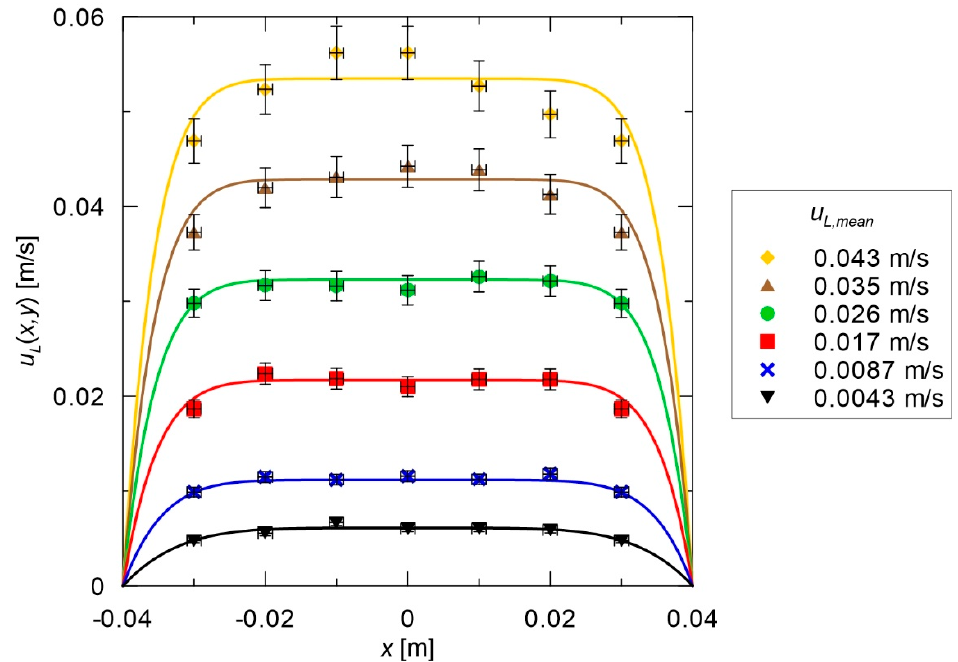
Figure2. Liquidvelocityprofilesforvariousmeanliquidflowvelocity; thepointsrepresentexperimental Figure 2. Liquid velocity profiles for various mean liquid flow velocity; the points represent data and the solid lines represent the calculated velocity experimental data and the solid lines represent the calculated velocity profiles.